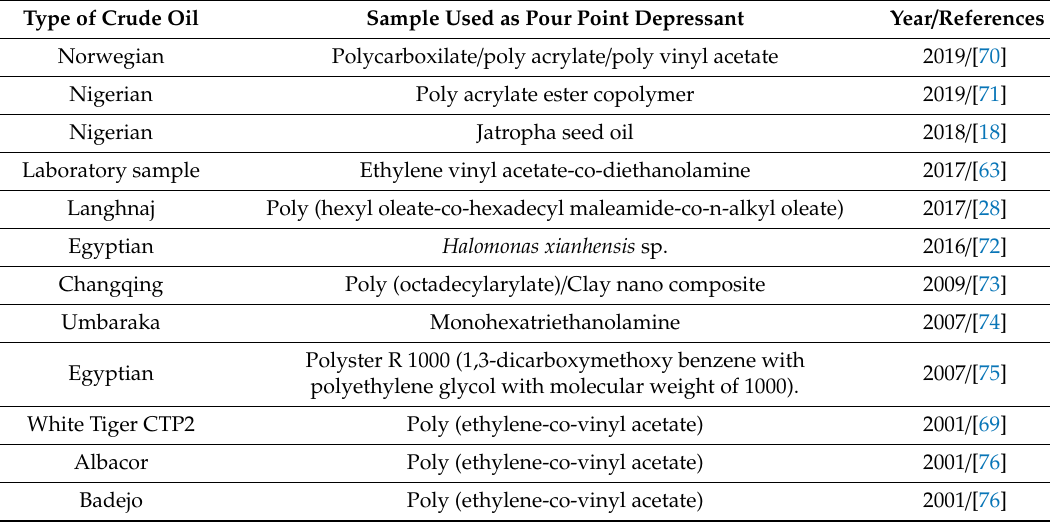
Table 3. Examples of pour point depressant used in was deposition